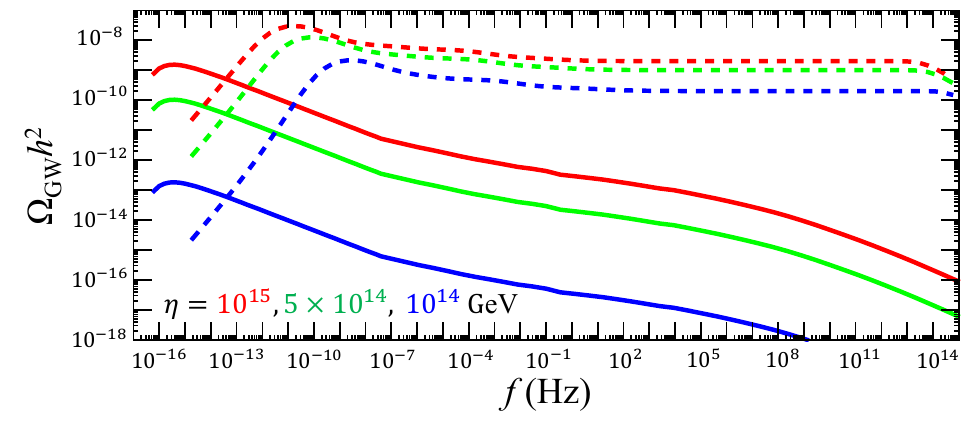
Figure 3 . Gravitational wave spectra from a global (solid) and NG (dashed) string network with α = 0 . 1 , F α = 0 . 1 , for η = 5 × 10 15 (red) , 10 15 (orange) , 5 × 10 14 (green) , and 10 14 GeV (blue). Up to k = 10 15 harmonic modes are included in the